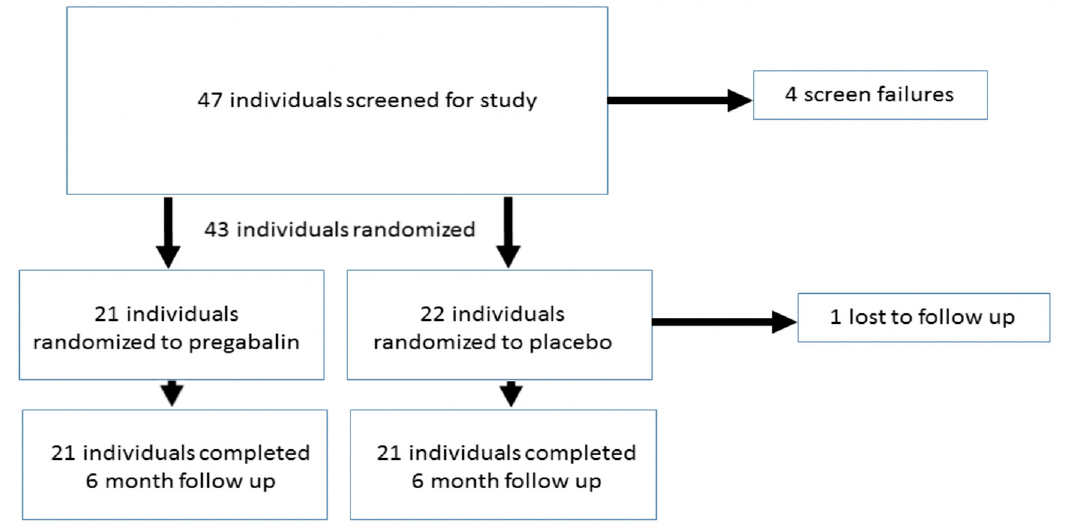
Figure 1. Patient Recruitment and Randomization Flow Chart.